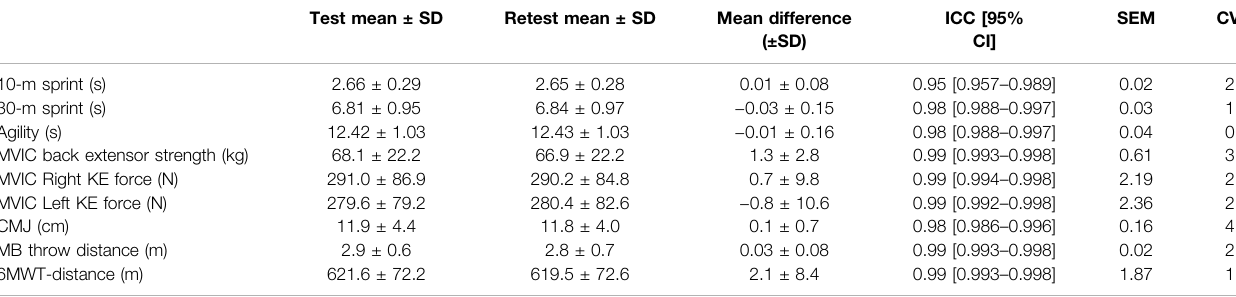
TABLE 3 | Test-retest reliability of physical fi tness